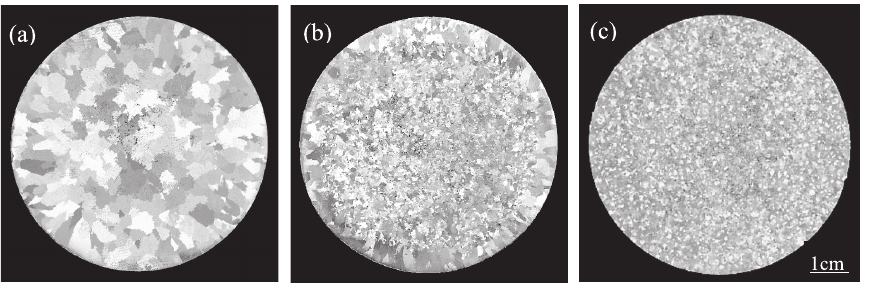
Fig. 5: Macrostructure of IN100 superalloy castings cross section in (a) I DC = 0A, I AC = 0A; (b) delay 10 s, I DC = 0A, I AC = 60A; (c) delay 0 s, I DC = 290A, I AC =